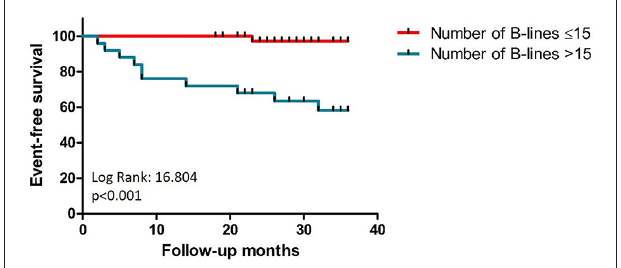
FIGURE 4 | Comparison of Kaplan-Meier curves for patients with and without B-lines >